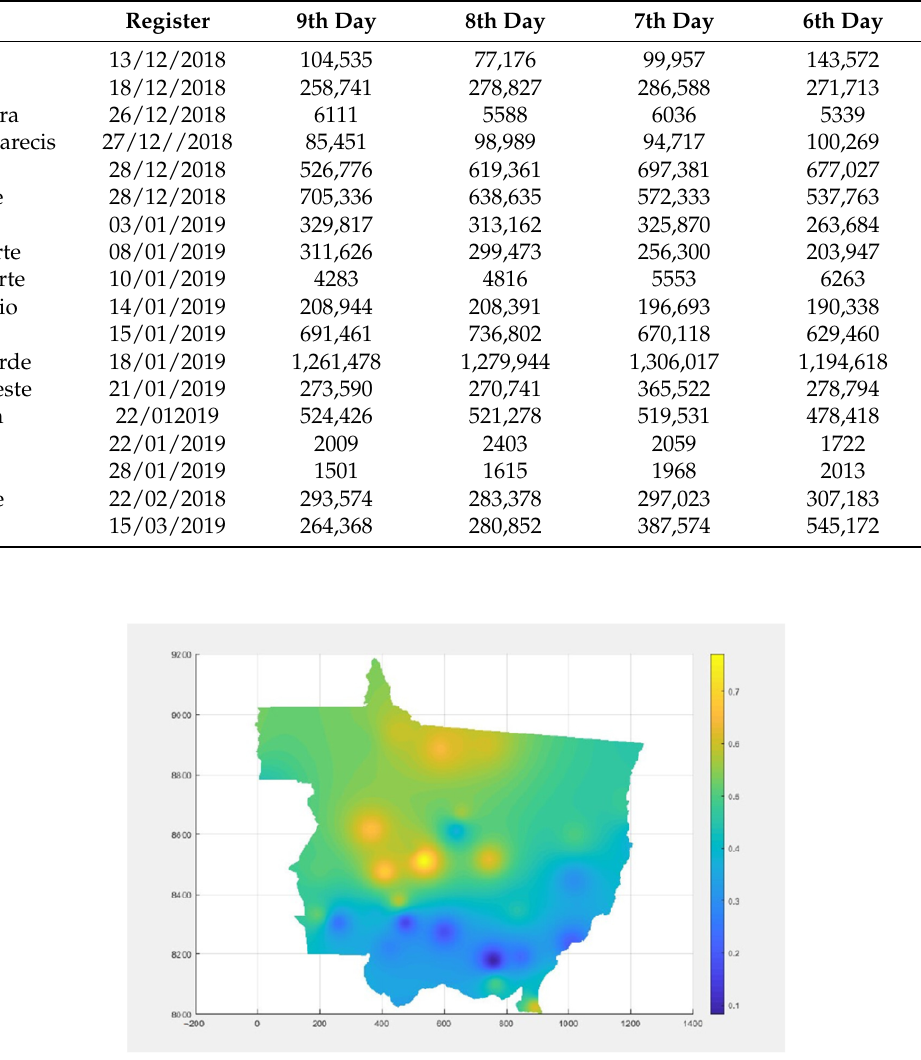
Figure 5. Map of favorability for the month of January 2019. Reference [39] compared three estimation methods for soil pH (inverse of